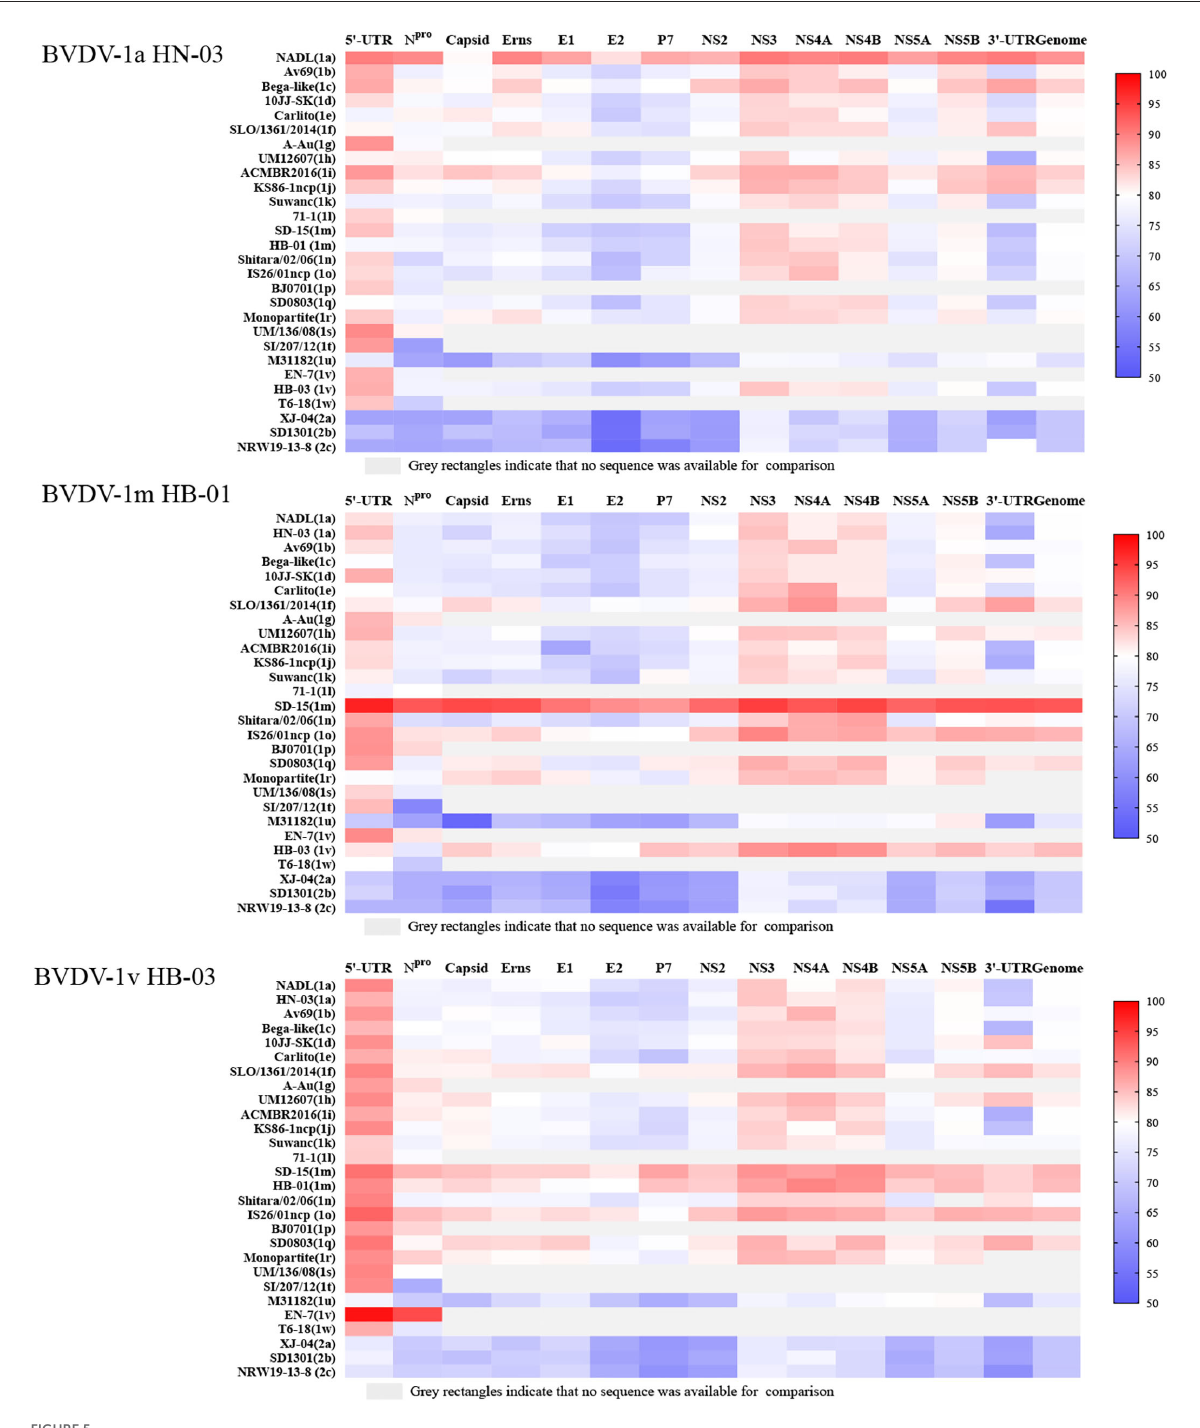
FIGURE5 Nucleotide sequence identity (%) comparison of each segment of the three bovine viral diarrhea virus (BVDV) isolates to other strains of BVDV-1 and 2. Information on the reference strains is shown in Supplementary Table 3.